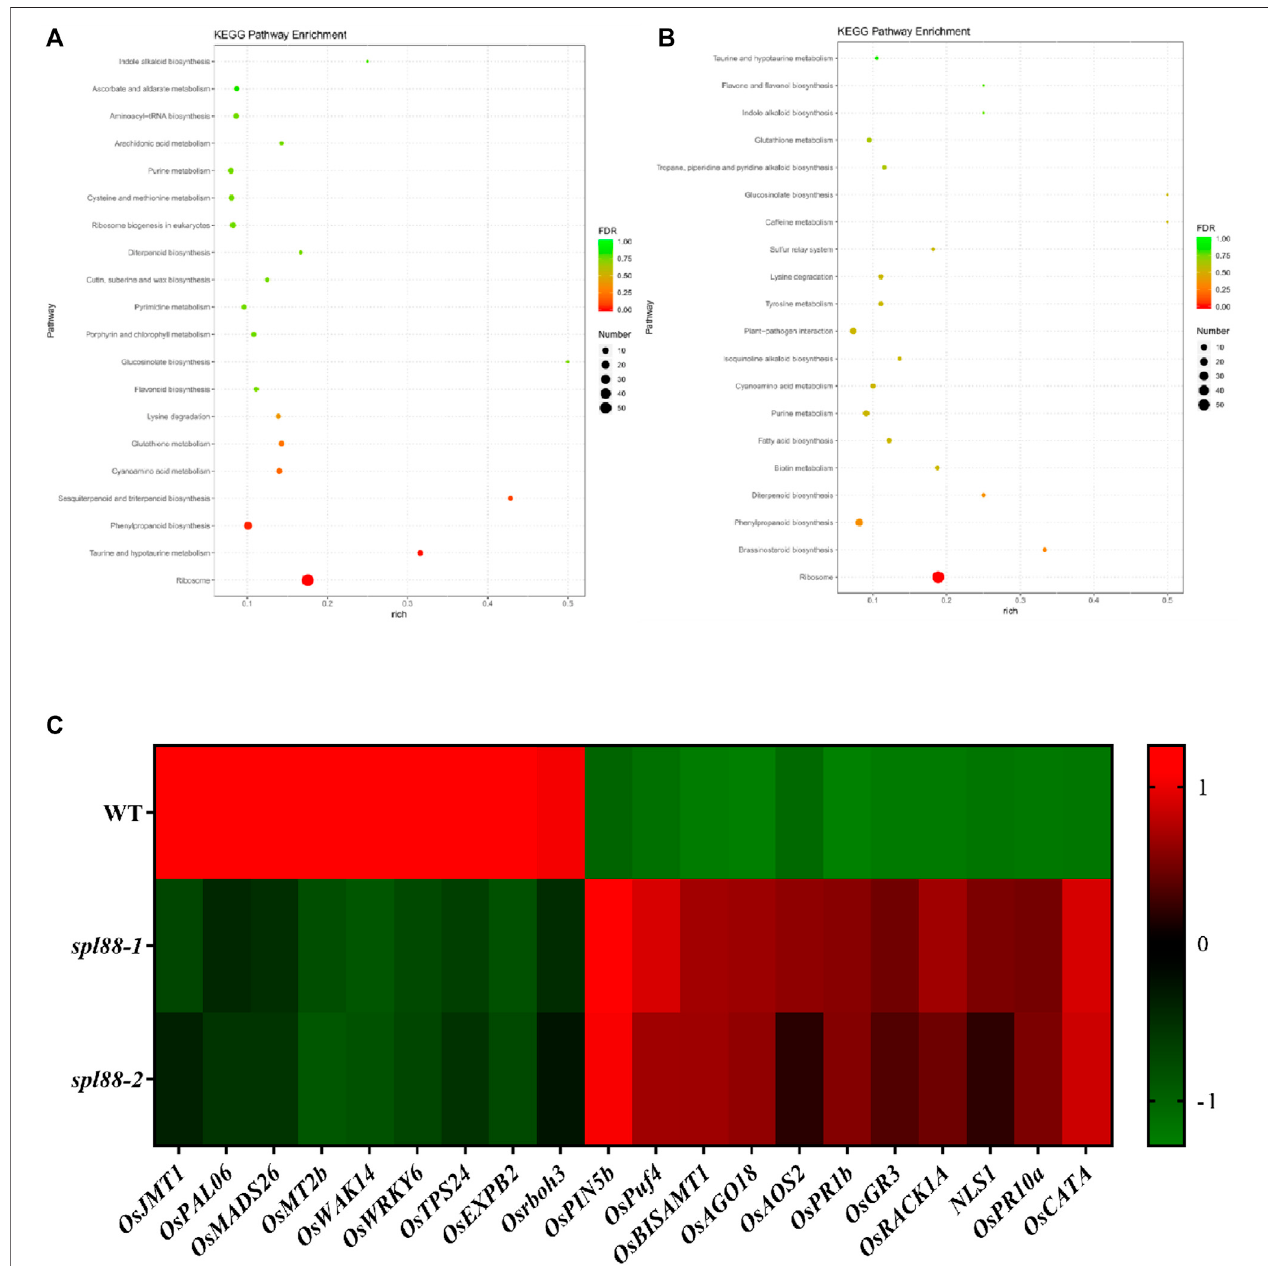
FIGURE 9 | Transcriptome pro fi ling analysis of spl88-1 and spl88-2 . (A) , (B) KEGG enrichment analysis of differentially expressed genes compared to wild type, spl88-1 , and spl88-2 ; (C) expression heat map of differentially expressed genes associated with defense and growth and development.